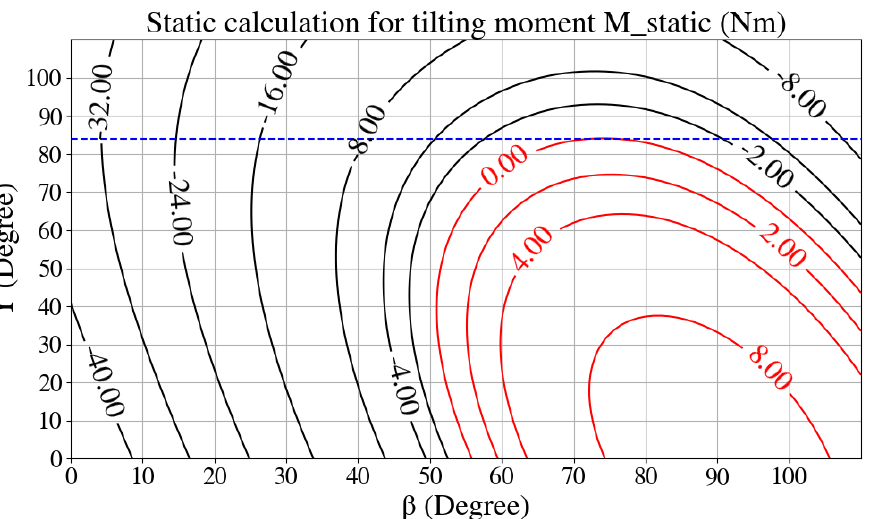
Figure 7. Estimation of tilting moment under static conditions for different angle configurations β and ϒ , based on the parameters obtained from CAD volume model of the mobile manipulator.